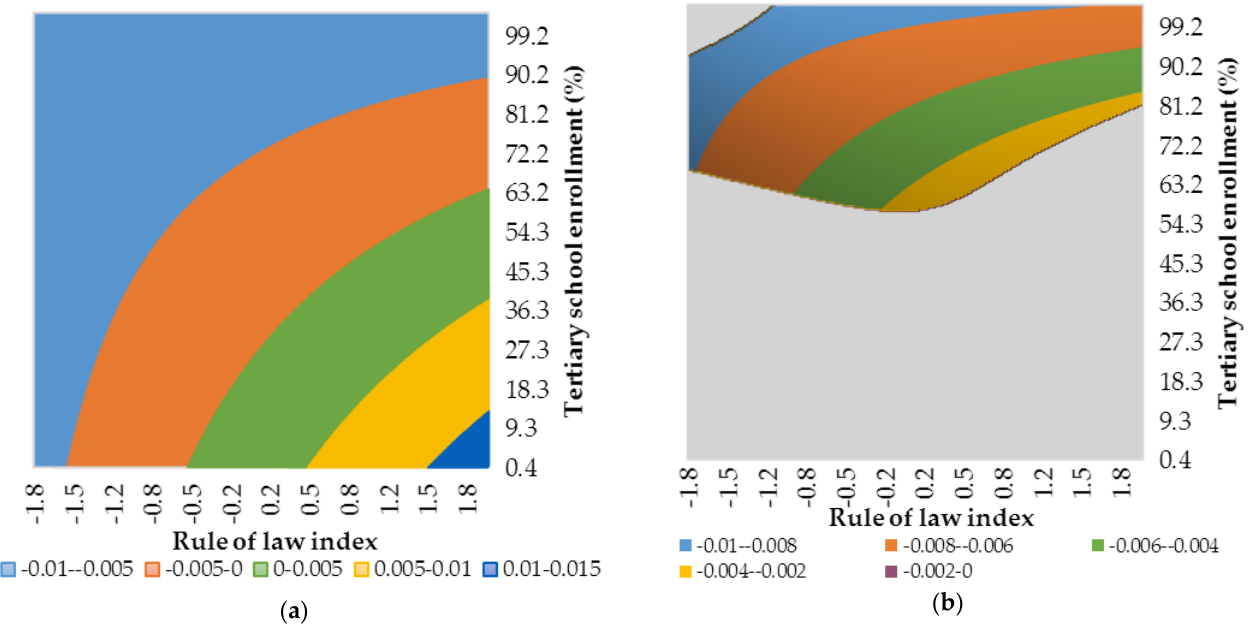
Figure A11. Conditional effect of financialisation on growth based on Est. 11 in Table A2. ( a ) Estimated conditional slope coefficient over the whole range of observed values for institutional quality and development level. ( b ) Estimated statistically significant conditional slope coefficient. Gray represents a combination of institutional quality and development level for which effect of financialisation on growth is statistically insignificant. Source: authors’ contributions.